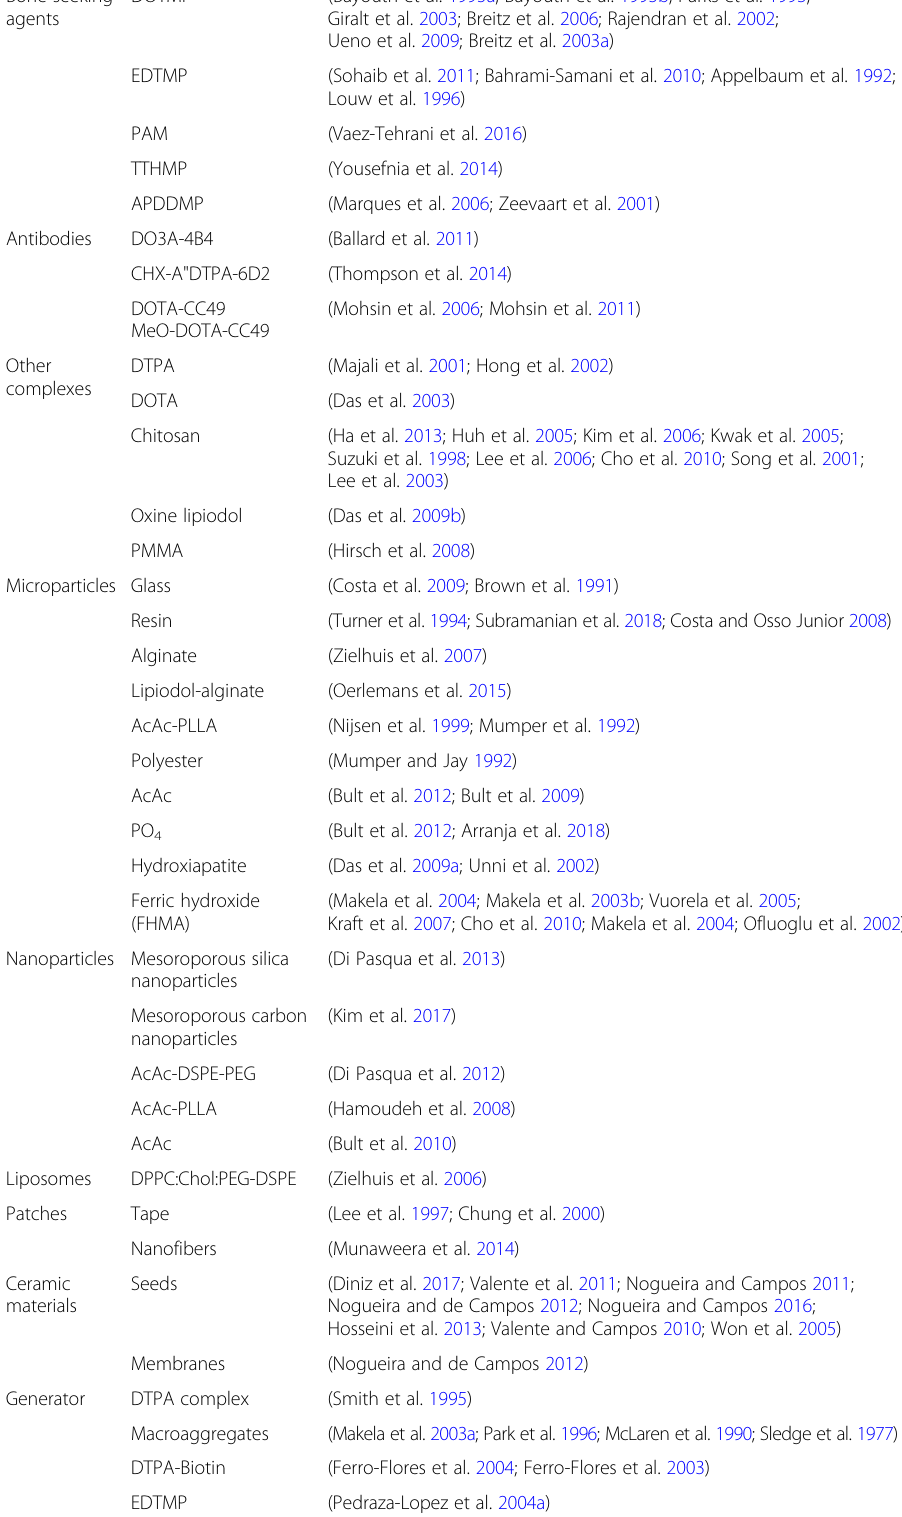
Table 1 Representative examples of carriers that have been loaded or conjugated to holmium and to the dysprosium/holmium